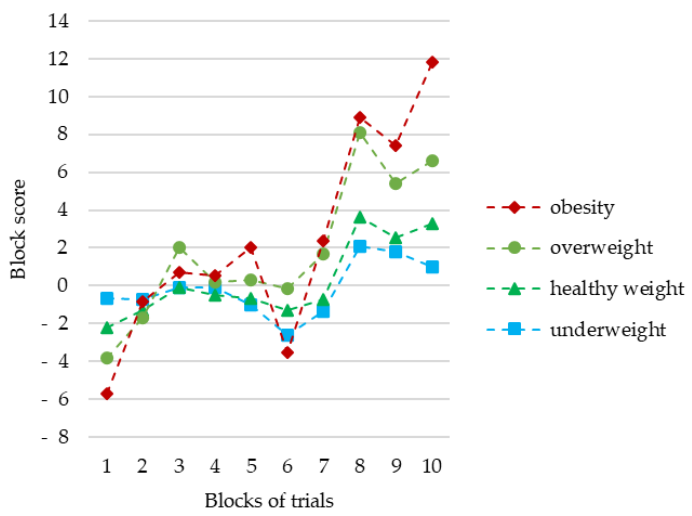
Figure 1. Mean scores by blocks of trials according to body mass status. No significant differences between the groups throughout the game ( p = 0.161). The effect of learning observed in the whole sample ( p =